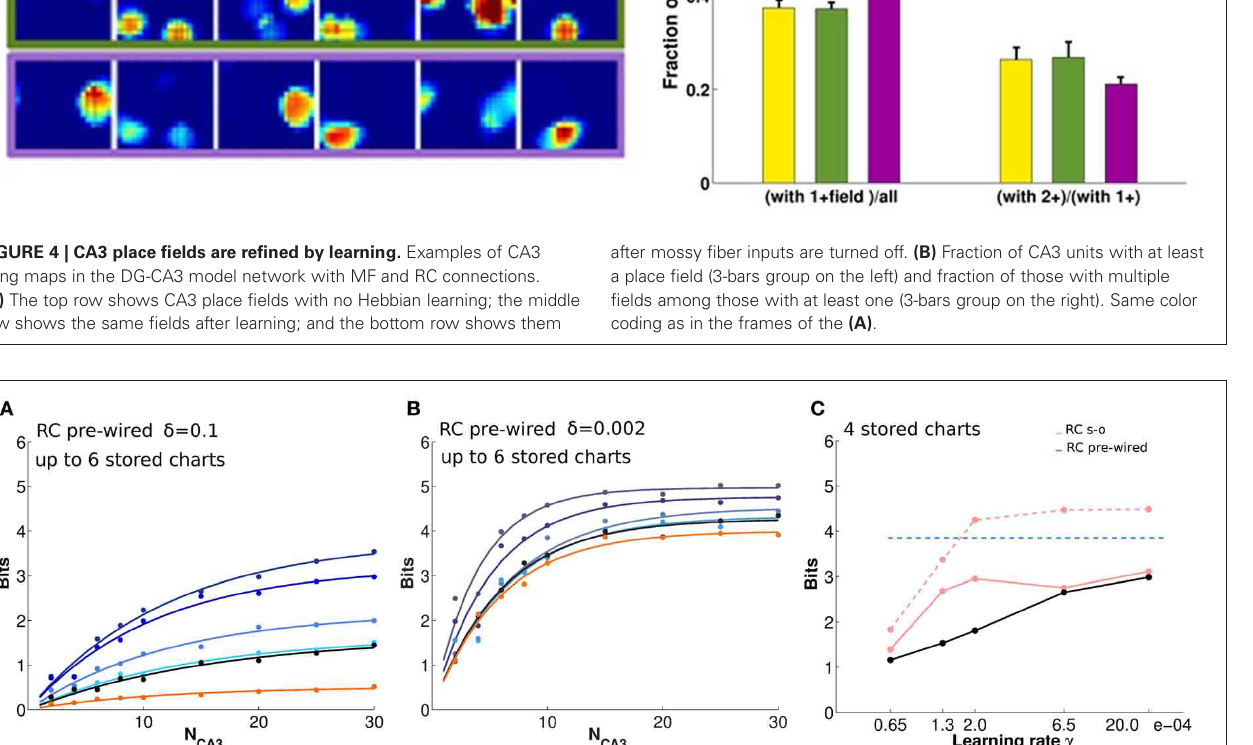
bottom (not shown). The orange curve is the information retained after reshuffling synaptic weights, as explained in the text. Dots correspond to information values obtained from simulations, while the curves results from fits to the data points, as detailed in Methods. (C) Position information retrieved from the last (dashed pink) and first (pink) of 4 charts stored in a network with Hebbian learning, from 10 CA3 units, as a function of the learning rate. The dashed blue line is the reference level for 4 pre-wired charts. The black segments connect residual information datapoints. A full cue was provided to initiate retrieval. Limited plasticity (a small learning rate) is sufficient for effective storage of multiple chats, while increasing the rate, in this case beyond γ = 0 . 0002, adds only to the residual